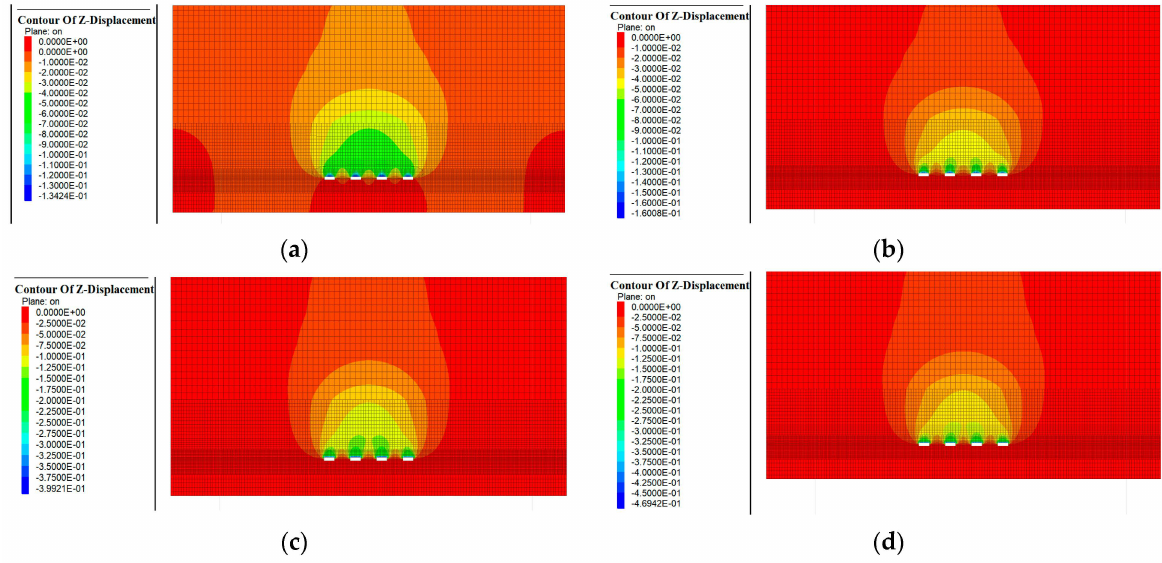
Figure 5. Displacements of rock strata in various conditions (m). ( a ) norm mining. ( b ) thermal stress. ( c ) rock burnt. ( d ) synergistic